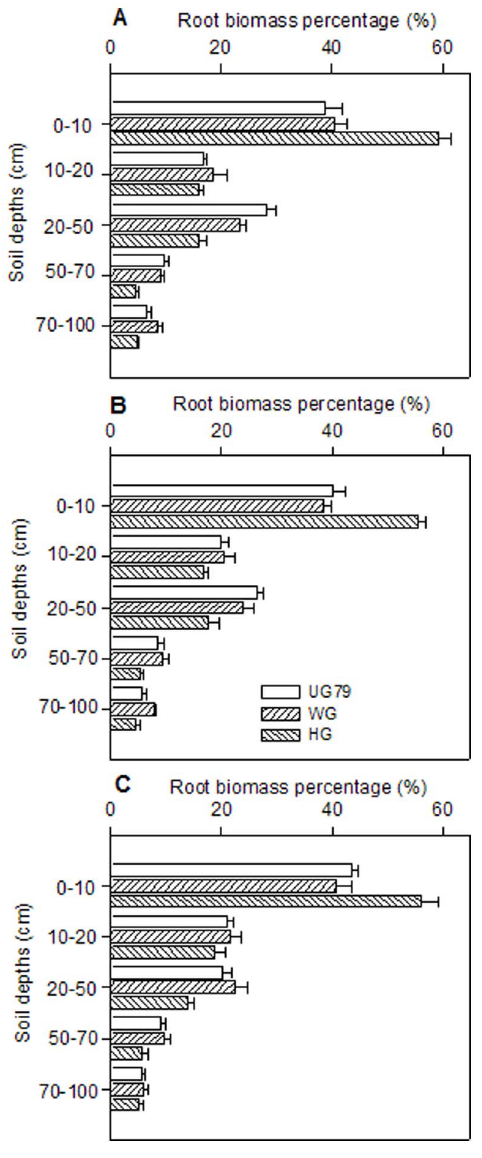
Figure 6. Relative distribution of root dry mass (%) in soil depths 0–100 cm. 2004 (A), 2005 (B), and 2006 (C). The data of each year were from three differently managed sites. Error bars represent mean 6 SE. Same symbols as in Figure